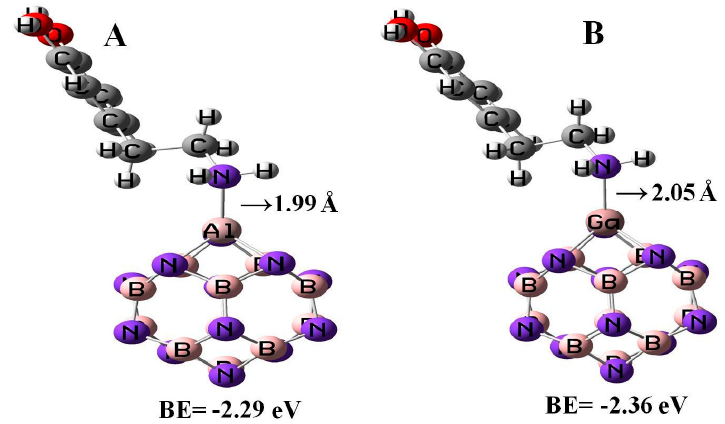
Figure 6. Adsorption of a single DPM over the Al –doped ( A ) and Ga-doped ( B ) B 12 N 12 nano-cages. Table 3. Calculated adsorption energy (E ad ), charge (e), HOMO and LUMO energies (E HOMO and E LUMO ), Fermi level energies (E F ), energy gap (E g ), dipole moment (D M ), and quantum molecular descriptors for optimized geometries of the DPM with Al- and Ga-doped B 12 N 12 nano-cages in the gas